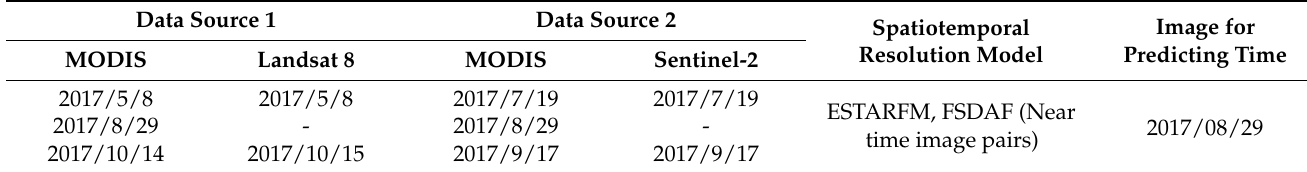
Table 1. Temporal comparison of spatiotemporal fusion data